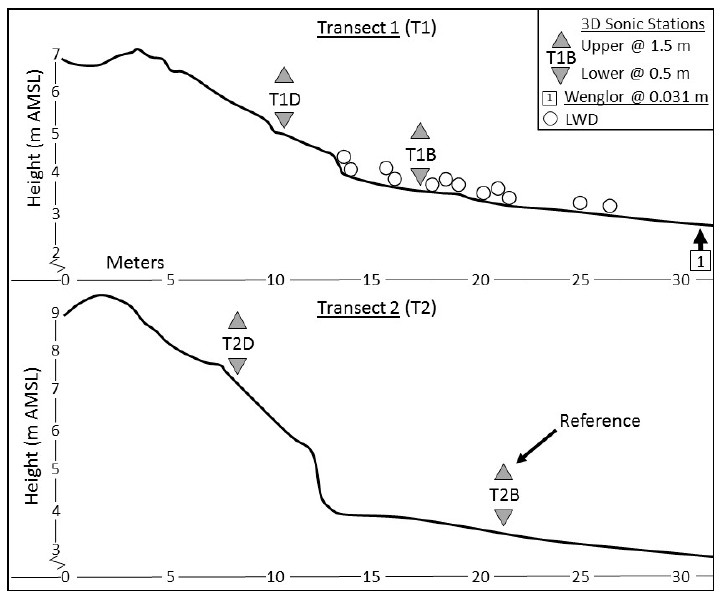
Figure 7. Diagram of instrument locations along shore-normal transects T1 and T2. 3D sonic anemometer stations are labeled by transect number (T#) and beach (B) and dune (D) locations. Individual anemometers are referenced by downward-pointing triangles (0.5 m) and upward-pointing triangles (1.5 m). Anemometers are henceforth referred to via these designations and heights in subscript, e.g., the Transect 1 anemometer on the beach at 0.5 m is referred to as “T1B 0.5 ”.